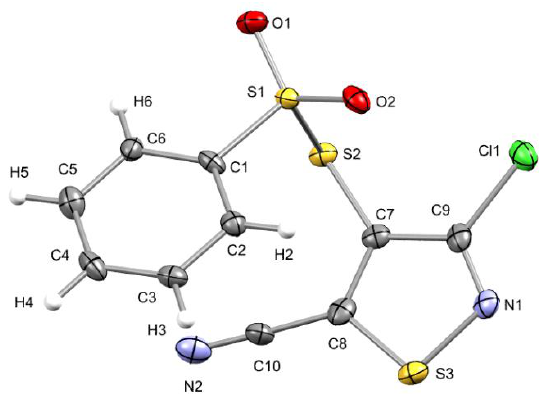
Figure 1. Geometry of S -(3-chloro-5-cyanoisothiazol-4-yl)benzenesulfonothioate ( 14 ) in the crystal; crystallographic atom numbering. Thermal ellipsoids at 50% probability.